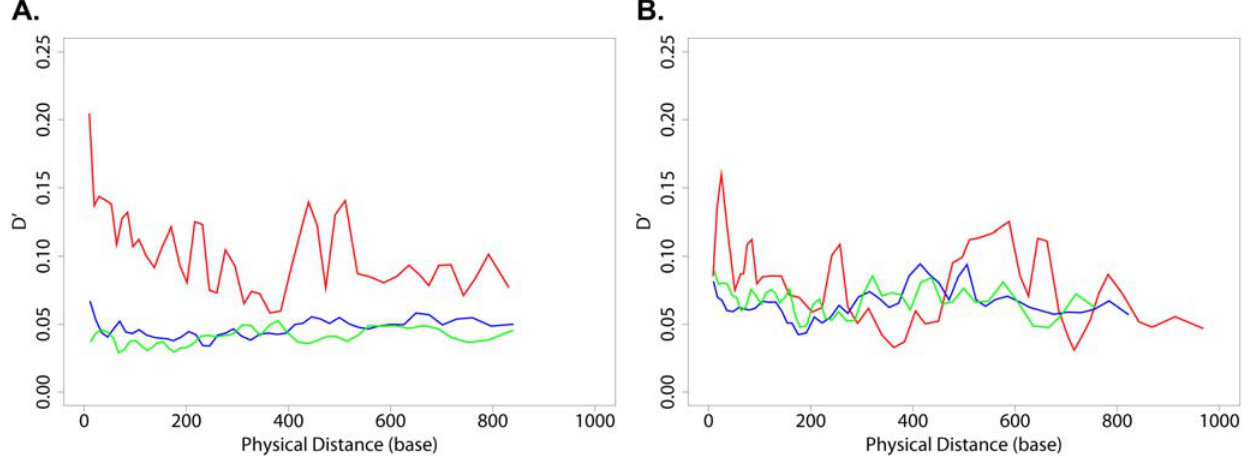
Figure 3. (A,A) Covariation Is Dramatically Higher than (A,S) and (S,S) Covariation in the Stanford-Treated Dataset but not the Stanford- Untreated Dataset. Sliding window results of average D 9 in A) Stanford-Treated Dataset and B) Stanford-Untreated Dataset. Amino acid mutation pairs (A,A), red; amino acid mutations to silent mutations (A,S), blue; silent mutation pairs (S,S), green. Each sliding window contains 4% of the data points in the